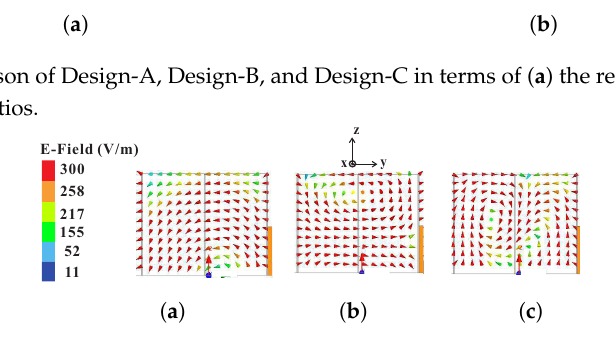
Figure 4. Simulated electric field at the center of a hexagonal DR for Design-B as observed along the x -axis at ( a ) 2.32 GHz; ( b ) 3.2 GHz; and ( c ) 3.77 GHz. Table 2. Calculated dielectric waveguide model (DWM) and simulated High-Frequency Structure Simulator (HFSS) resonance frequencies of different TE-modes excited in the hexagonal dielectric resonator